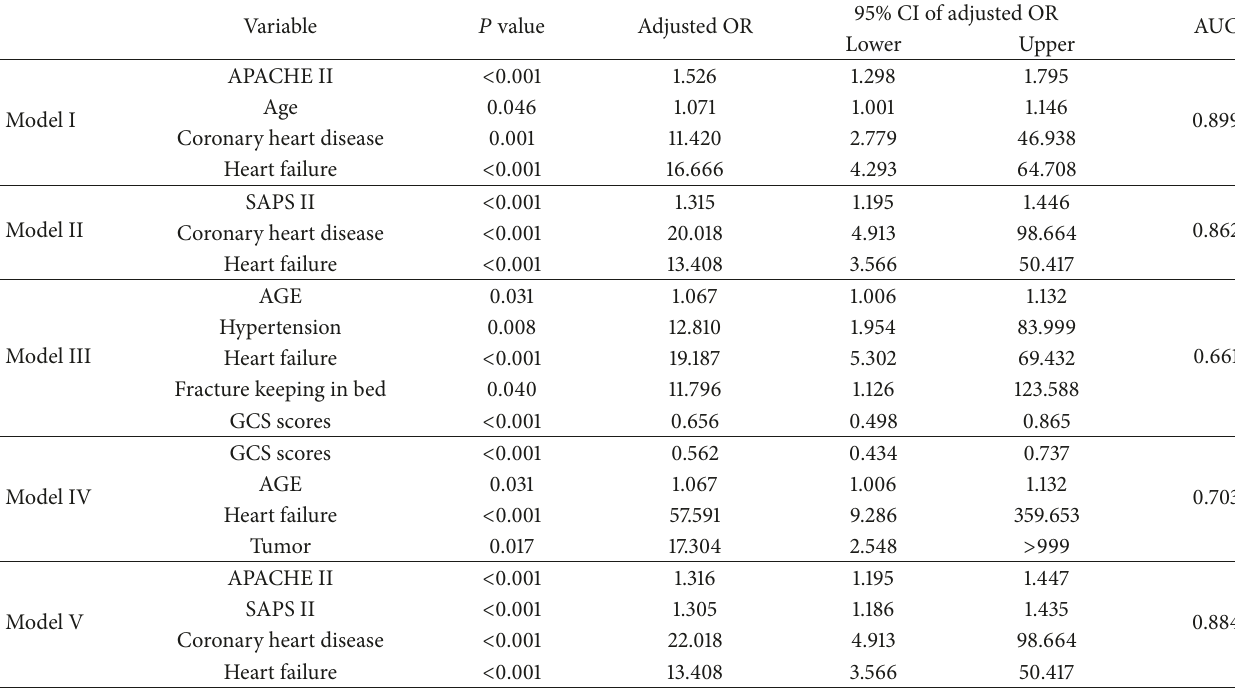
Table 3: Logistic regression analysis of the four severity-of-disease scoring methods.